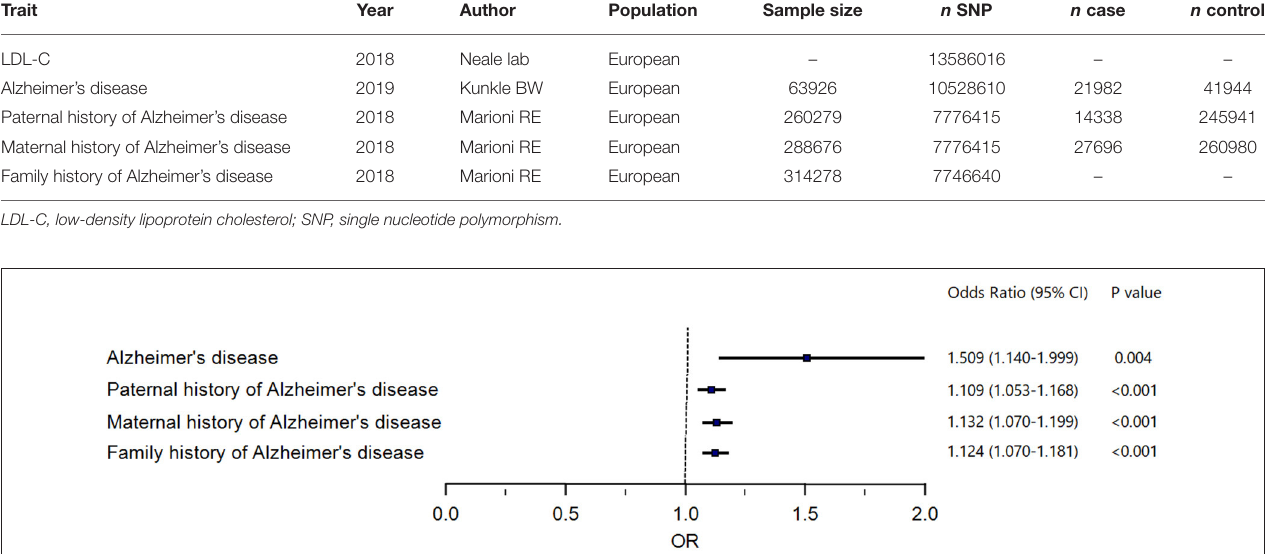
TABLE 1 | Baseline characteristics of LDL-C and Alzheimer’s disease. Trait